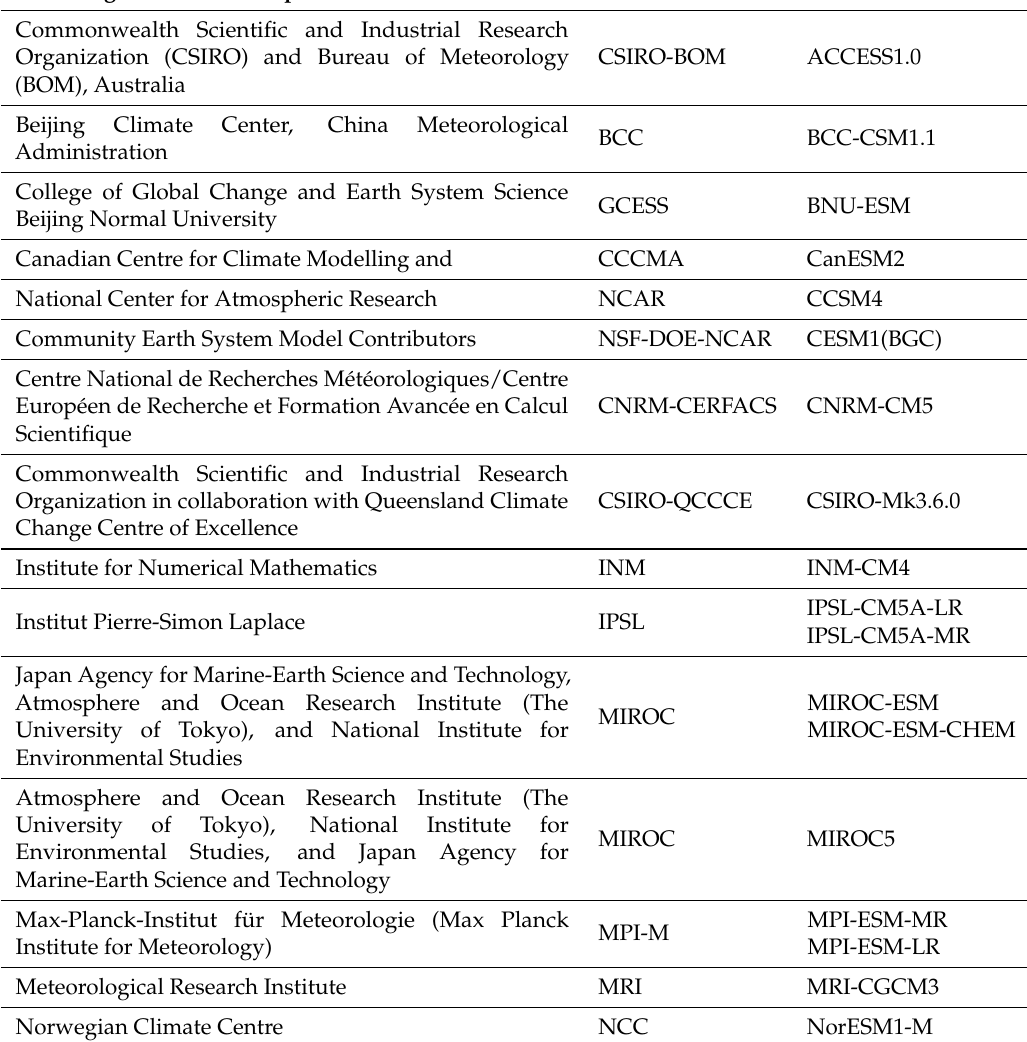
Table 1. List of models from the CMIP5 multi-model ensemble used in this paper. Modeling Center (or